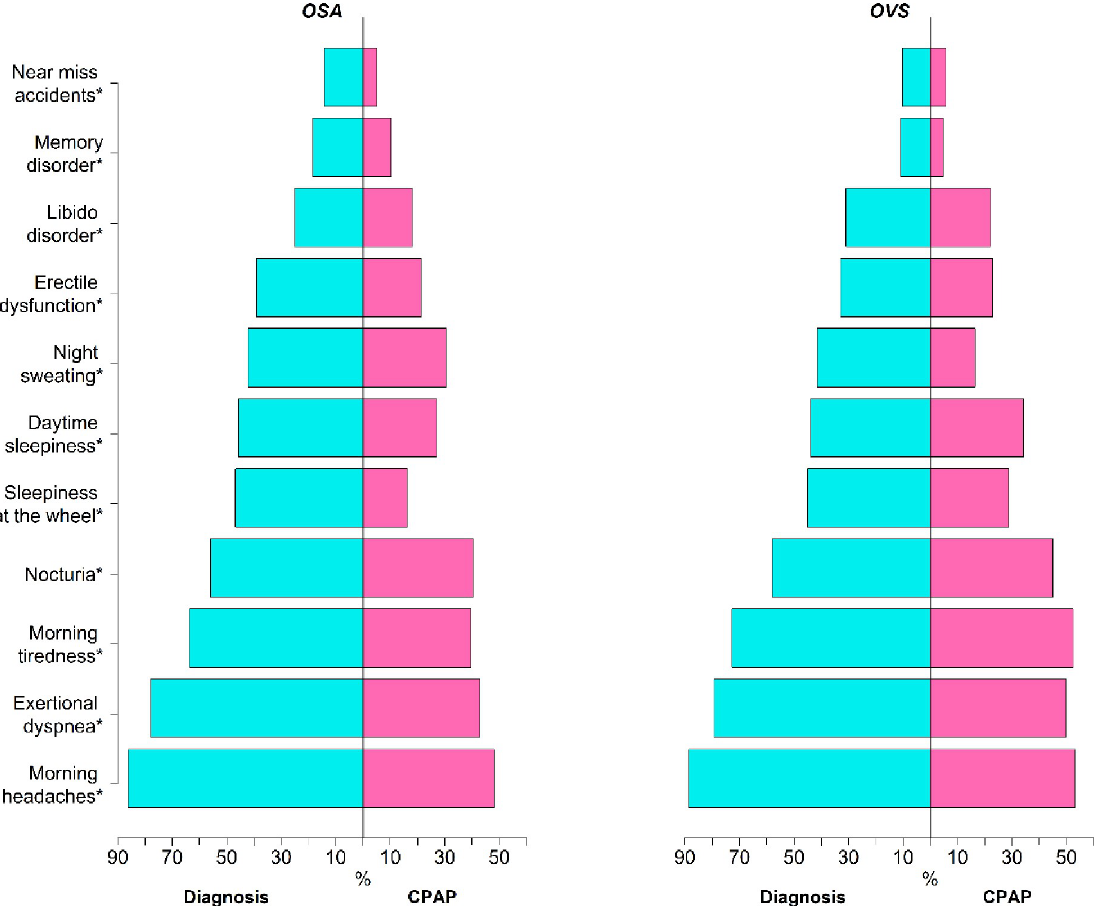
Fig 1. Proportion of symptoms at baseline (blue) and follow-up visit (pink) in OSA patients (left) and OVS patients (right). � denotes a significant difference between baseline and follow-up visit.